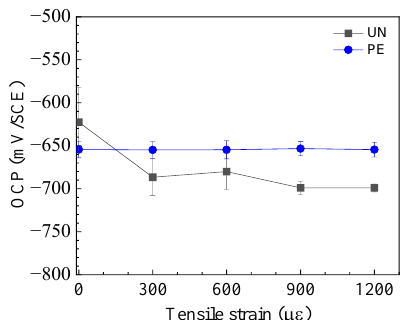
Figure 4. Open circuit potential of uncoated (UN) and enamel (PE)-coated steel rebars at different strain levels in 3.5 wt.% NaCl solution.